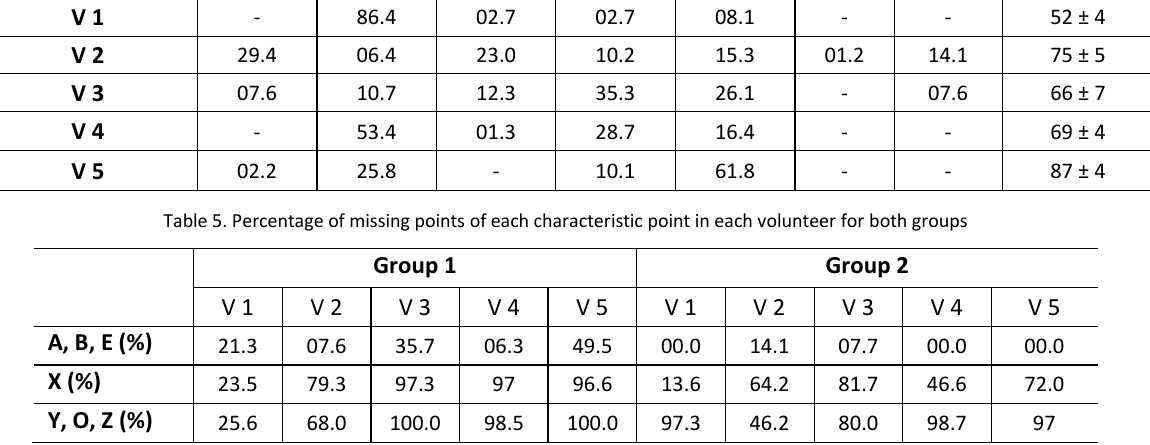
algorithm fixes a percentage from the period of CC intervals to be scanned.